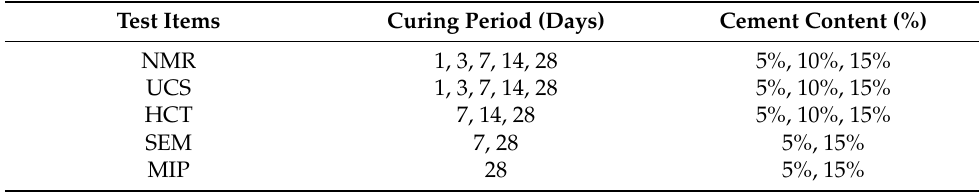
Table 3. Mix design and testing